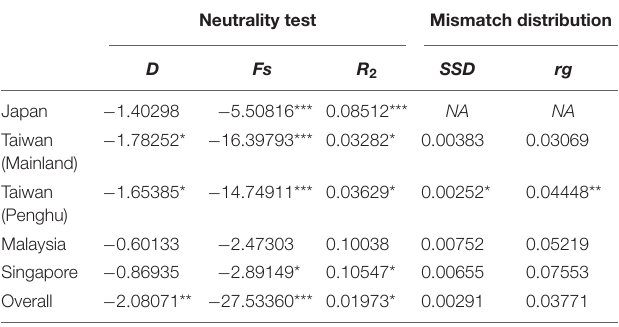
TABLE 3 | Summary statistics of historical demography for Eriphia ferox populations under investigation. Neutrality